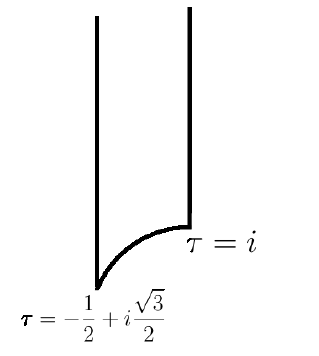
Figure 1 . Fundamental domain for the modulus (cid:28)